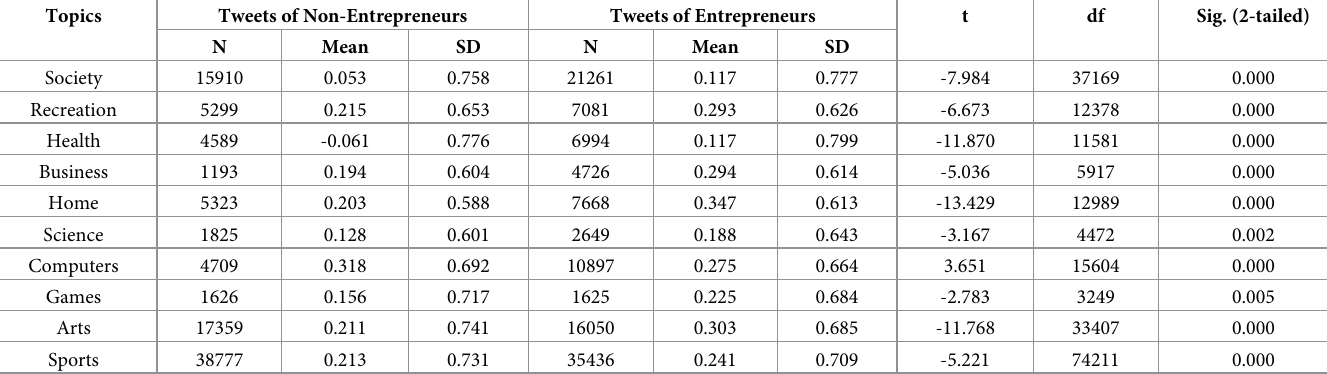
Table 8. Two-sample t-test to compare the mean emotional score per topic between entrepreneurs and non-entrepreneurs (Los Angeles data).